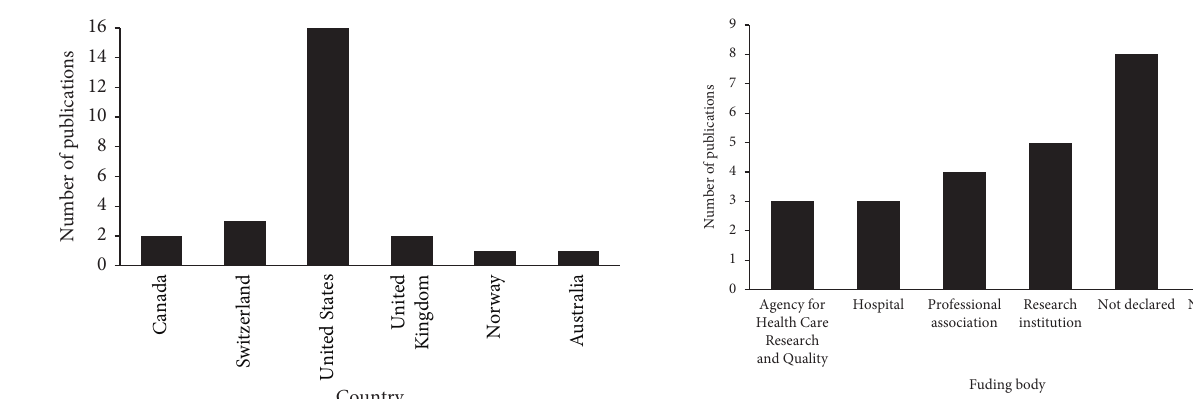
Figure 4: Sources of funding of the selected studies ( n � 25).